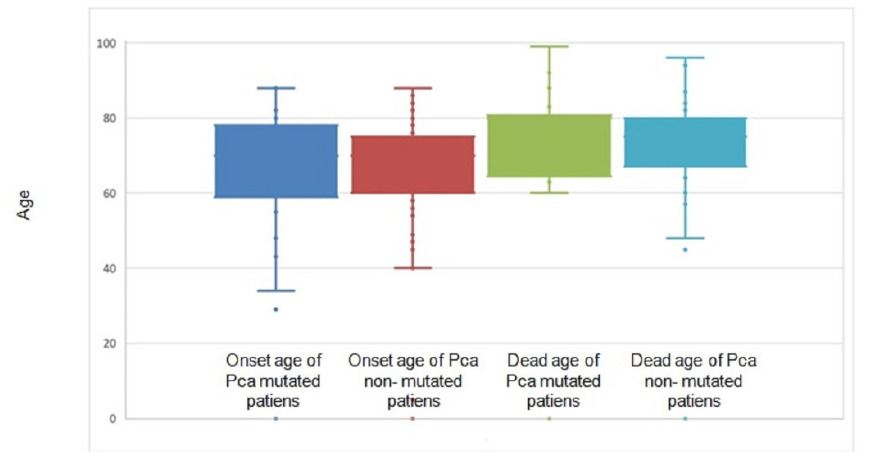
Figure 3. Onset age of 217 PCa patients. HBOC-mutated families included 49 individuals, and non-mutated families 168 individuals. Age of death of 66 PCa patients is also illustrated in this plot.